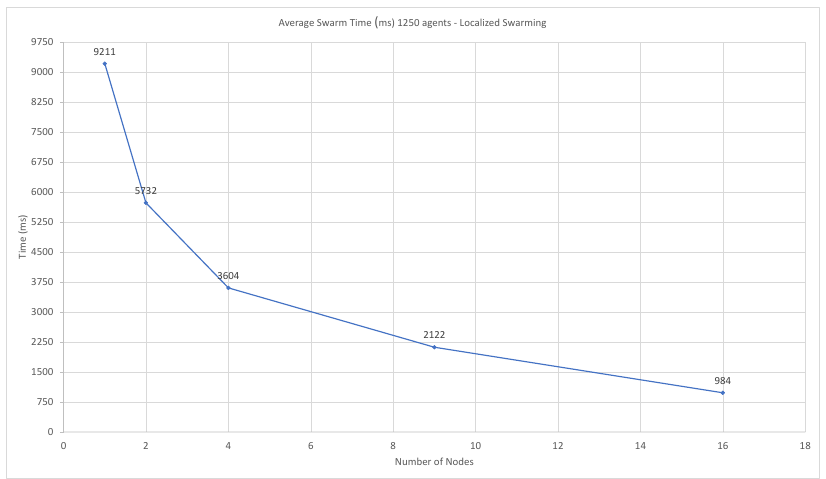
Figure 11. Swarm timing (ms) for 1250 agents on 1, 2, 4, 9, and 16 nodes, using data from Section 2.2.1 with cellular morphology features, with node-localized